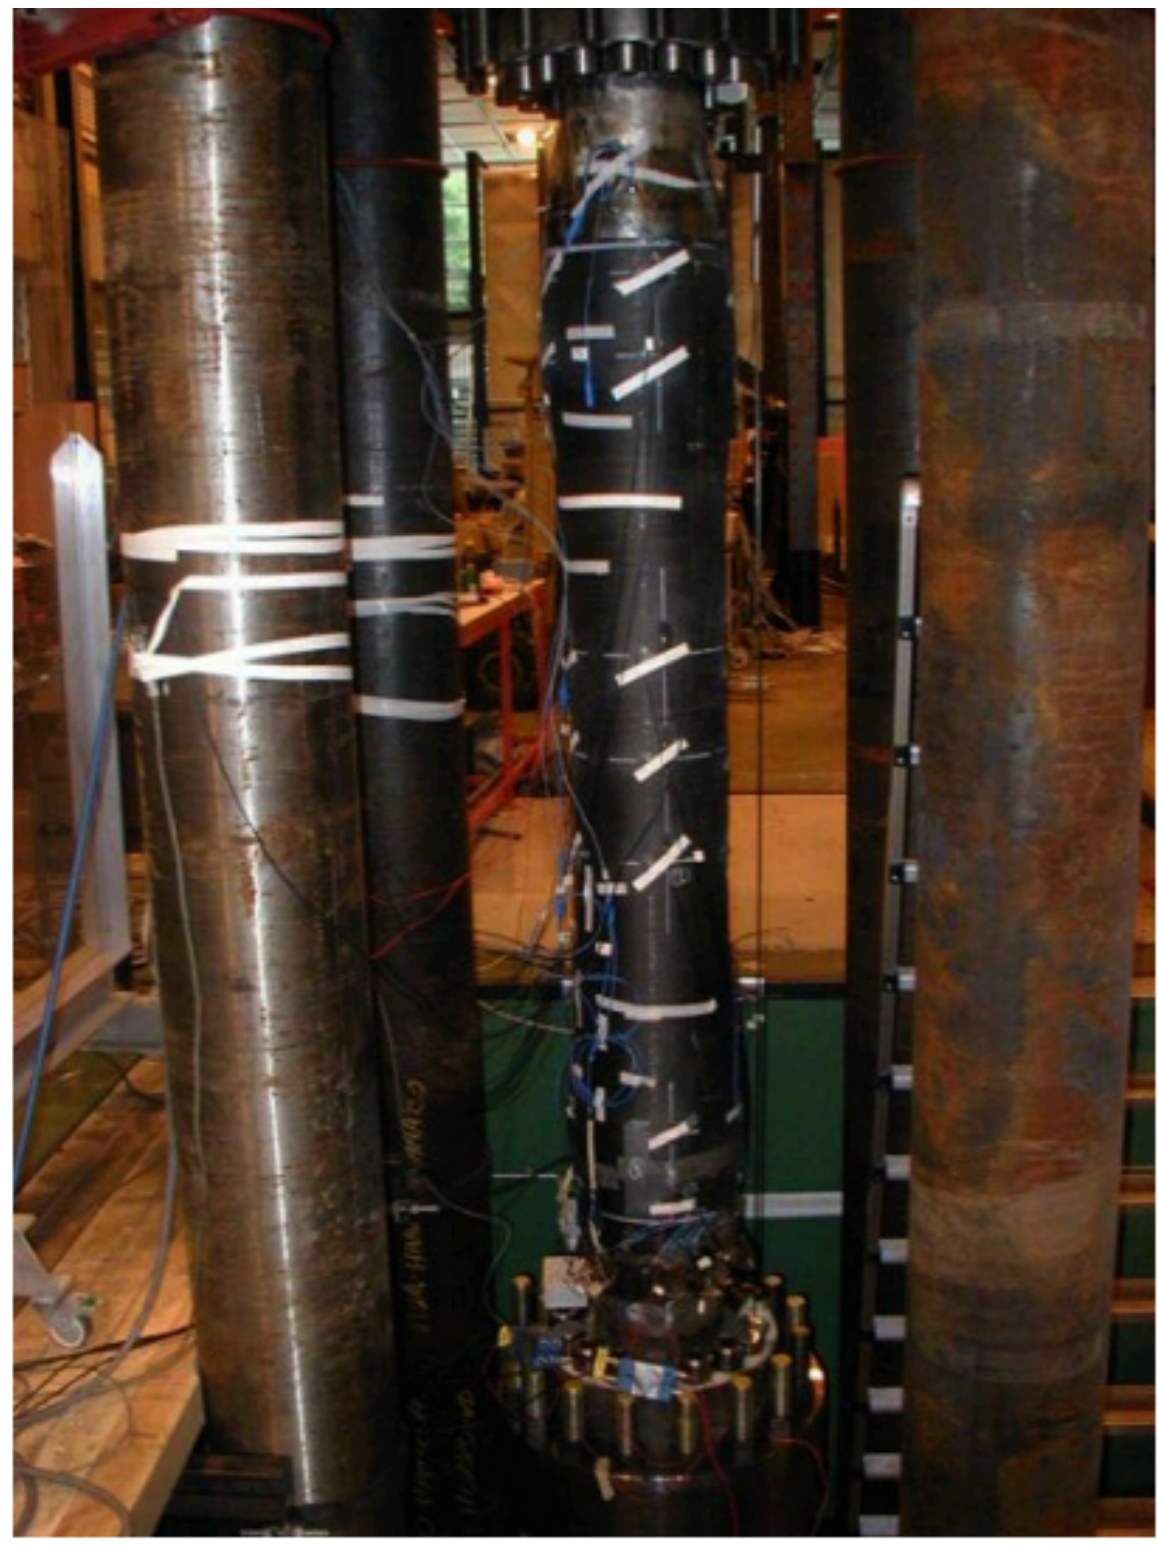
Figure 3. A fatigue testing rig for composite marine riser showing sensors, cables, and other moni- toring devices used (Reprinted/adapted with permission from Ref. [109]. Copyright year: 2014, cop-